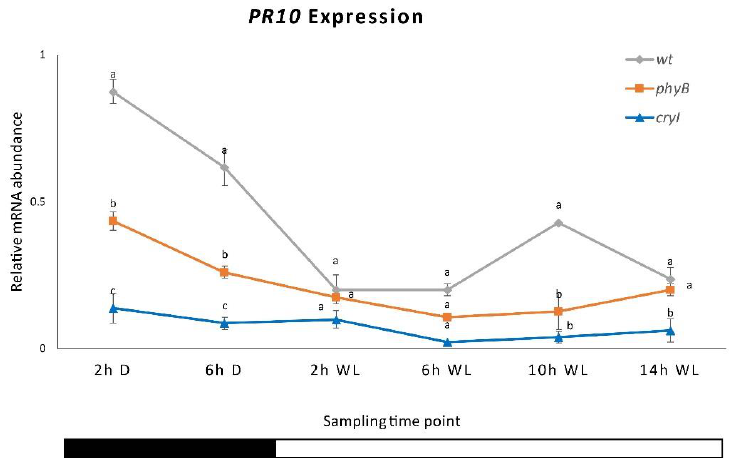
Figure 7. PR10 expression in Dar Gazi-wt , Dar Gazi-phyB , and Dar Gazi-cry1 . Results are presented after normalization with ef1A . Data shown as the average of two biological replicates run in triplicate, with error bars representing SD. At each time point, values with different letters significantly differ according to the analysis of variance (ANOVA) and least significant difference (LSD) tests ( p ≤ 0.05). The bars under the horizontal axis show the light and dark periods.